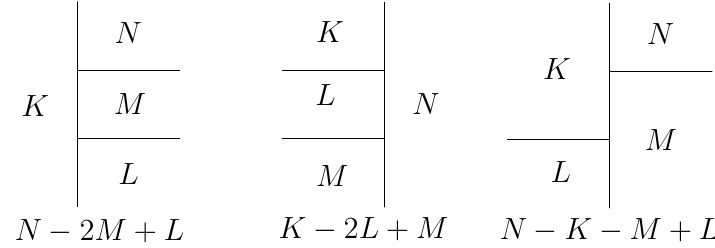
Figure 7. Shift parameters associated to di(cid:11)erent (cid:12)nite segments of the